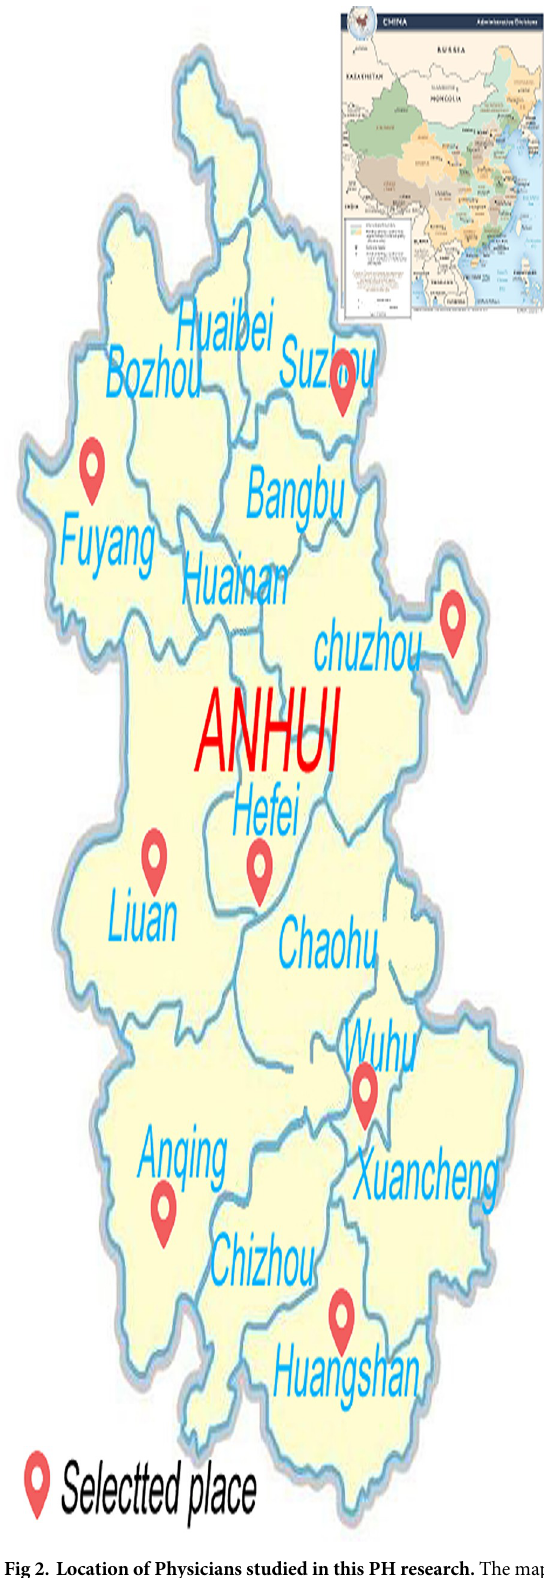
Fig 2. Location of Physicians studied in this PH research. The map of China in the picture is extracted from CIA website. Hint: the relative location of Anhui province, China and the world. https://doi.org/10.1371/journal.pone.0228152.g002 PLOS ONE | https://doi.org/10.1371/journal.pone.0228152 January 29,